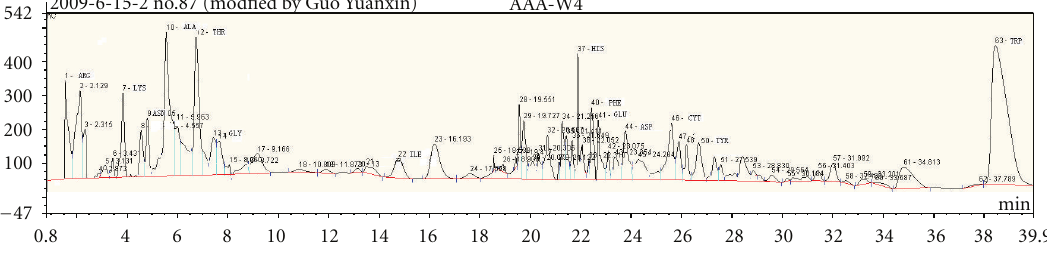
Figure 2: Total ion current of a normal subject